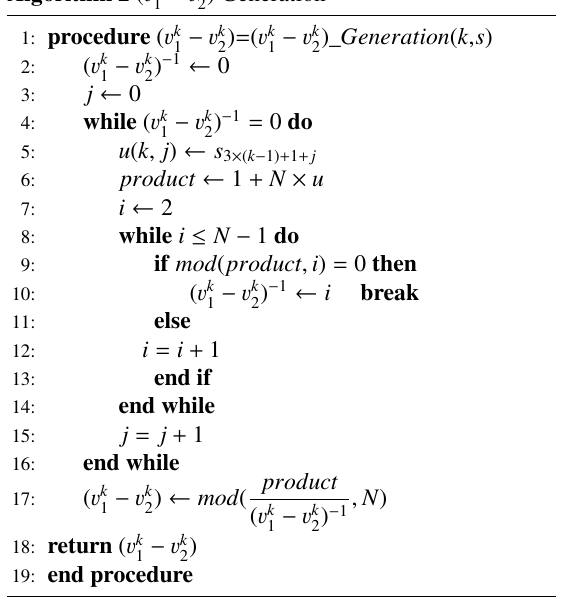
− v k ) Generation 1 2